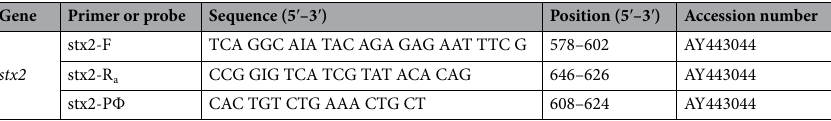
Table 2. Primers and probes for qPCR quantification of stx2d 55 . Ф Probe tagged with minor groove-binding non-fluorescent quencher (MGBNFQ) and 6-carboxyfluorescin (FAM) fluorescent label